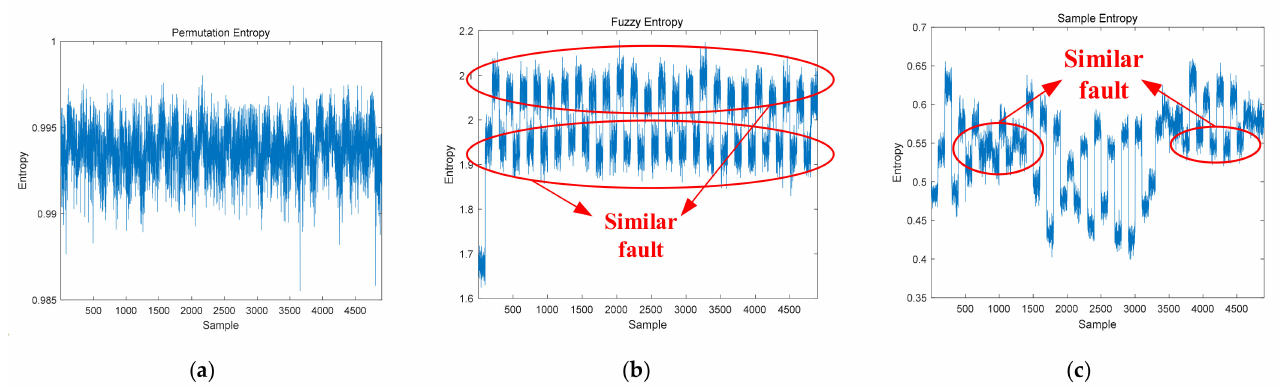
Figure 3. Different entropy of different fault signals: ( a ) permutation entropy; ( b ) fuzzy entropy; ( c ) sample entropy.